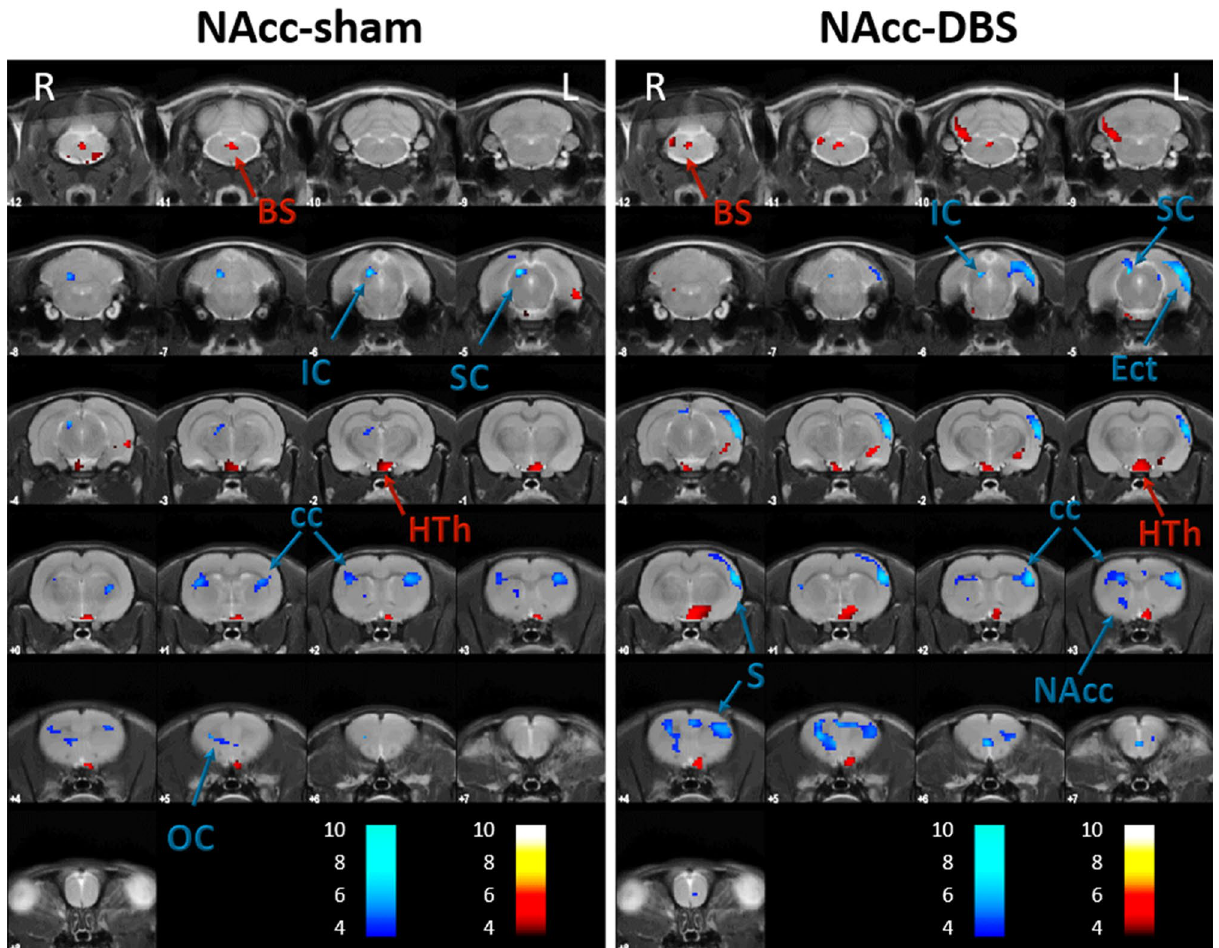
Figure 3. Persistence of DBS effects on brain metabolism 1 month after finishing NAcc-DBS treatment. Colored PET overlays on the MR reference represent the T-maps resulting from the post-1-month vs. post-1- day comparisons, indicating increased (hot colors) or decreased FDG uptake (cold colors), in NAcc-sham (left) and NAcc-DBS (right) animals, respectively. The color bars represent the T values scale corresponding to the PET overlays intensity. Hemispheres: Left (L), Right (R). BS brainstem, cc corpus callosum, Ect ectorhinal cortex, HTh hypothalamus, IC inferior colliculus, NAcc nucleus accumbens, OC orbital cortex, S somatosensory cortex, SC superior